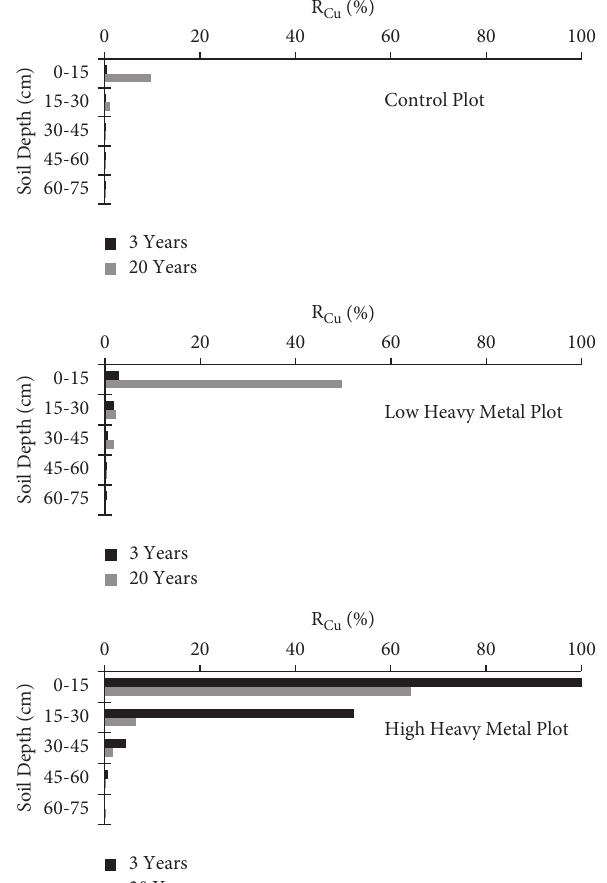
Figure 7: The vertical spatial distribution of soil Cu 3 years 1) and 20 years 2) after amendment with Cu-Zn containing industrial waste (R the ratio of the actual concentration to the highest concentration of Cu in the 60Mg waste ha − 1 plot (93.3 mg · kg − 1 ); waste at CP � 0, LMP � 15, and HMP � 60Mg · ha − 1 ; 1) after [42]; 2) after Fernando and Salam (unpublished data